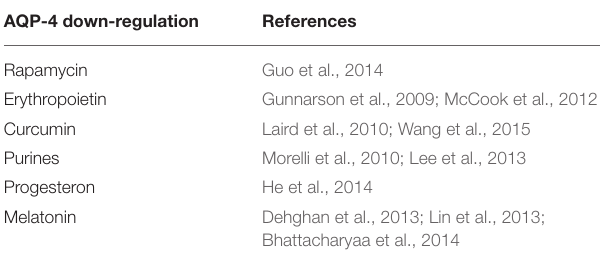
TABLE 2 | Neuroprotective compounds associated with AQP-4